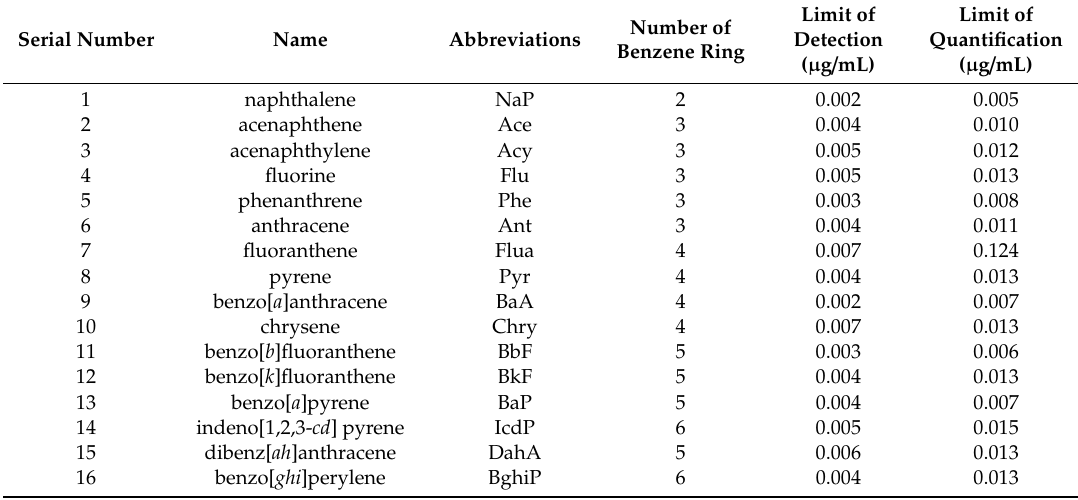
Table 4. 16 USEPA polycyclic aromatic hydrocarbons (PAHs) names and